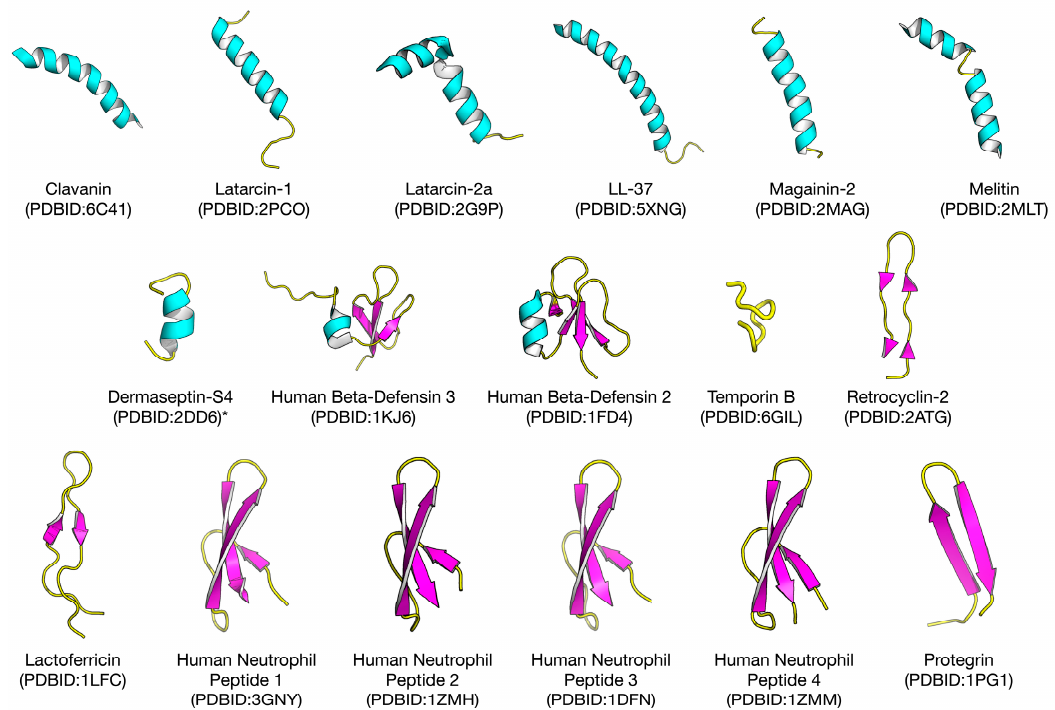
Figure 1. Structures of selected antiviral peptides that have been experimentally elucidated. Each structure is labelled by a common name followed by the Protein Data Bank Identification number (PDBID) in parenthesis on the subsequent line. * Dermaseptin-S4: The structure and available PDBID is that of a truncated peptide, which was experimentally tested to be e ff